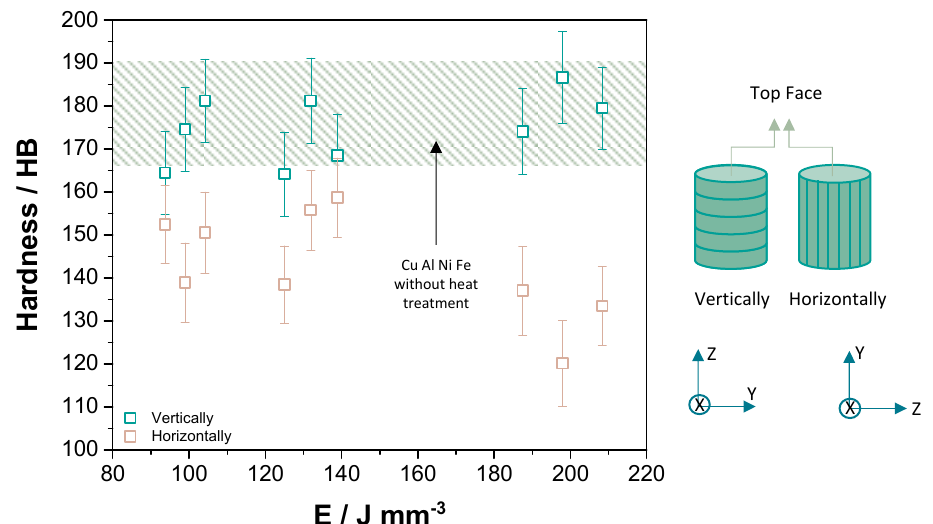
Figure 6. Hardness (HB) of samples fabricated vertically and horizontally as a function of volumetric energy density.